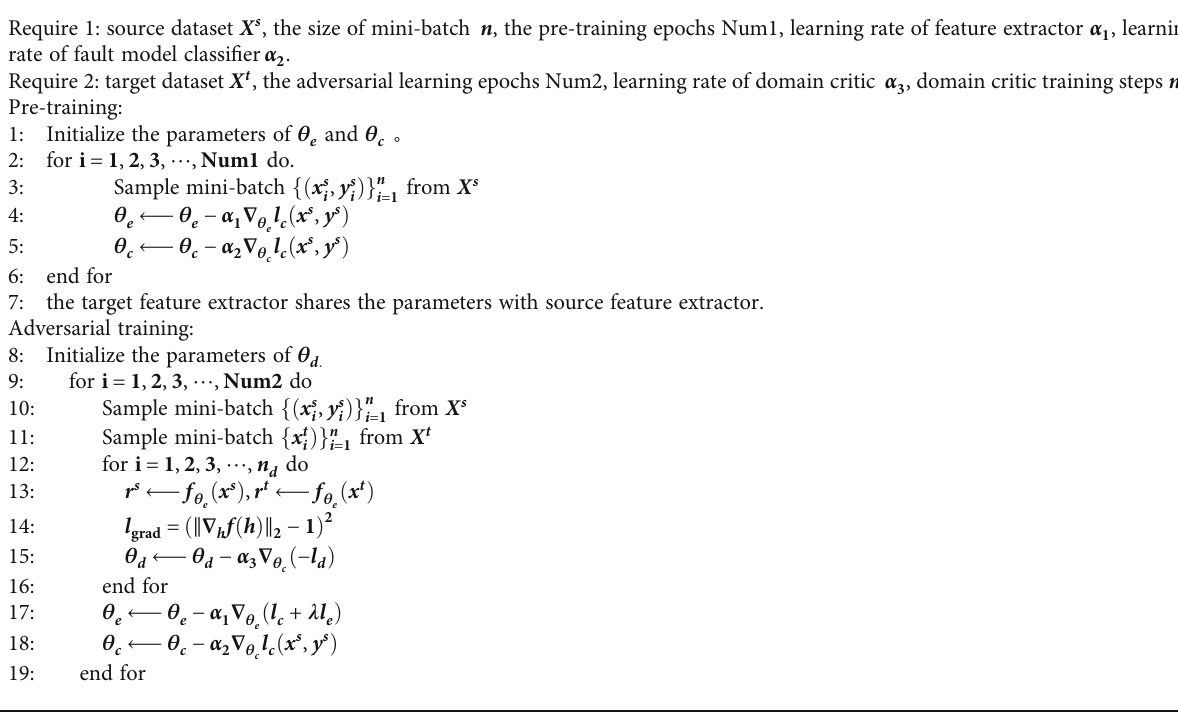
Algorithm 1: Training strategy and procedure of